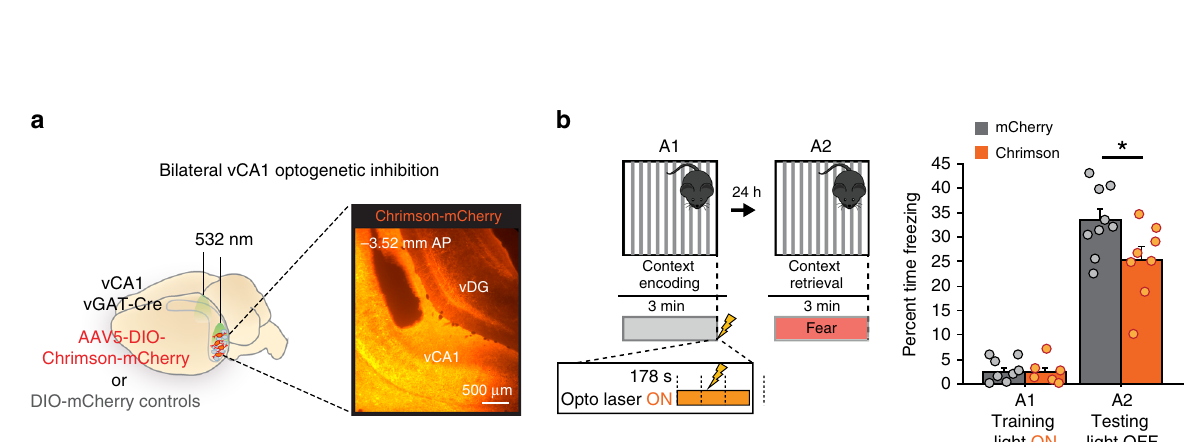
Fig. 2 Correlated activity with vCA1 shock cells is proportional to memory strength. a Experimental design for vCA1 Ca 2 + imaging in contextual conditioning. GCaMP6f was virally expressed and a GRIN lens implanted to target the vCA1 pyramidal layer (left). Ca 2 + activity was imaged across days; Mice received a footshock at the end of A1 (right). The main effect of increased correlated activity in vCA1 during memory retrieval was replicated in fi ve independent datasets. b Correlation graph analysis design; Top: mock traces of Ca 2 + events demonstrating calculation of signi fi cantly correlated pairs (Pearson ’ s R > 0.3, cell 1 correlated with cell 2, but not cell 3). Bottom: Example of a correlation graph with extrapolated graph parameters constructed using Pearson ’ s R correlation matrix. Cell pairs with signi fi cant correlation coef fi cient are connected by a line. c Proportion of vCA1 shock cell correlated pairs with other shock cells (red) or non-shock cells (blue). d Representative correlation graphs with vCA1 shock cells colored in red, and their correlated pairs during context retrieval (A2 shock-partners) colored in blue across conditioning days. e – g Graph parameters of vCA1 shock cells (red), A2 shock- partners (blue), and all other cells (A2 non-shock-partner, black) across conditioning days ( N shock = 111, N A2 shock-partner = 121, N A2 non-shock-partner = 616; Kruskal – Wallis between groups with Bonferroni alpha correction; corr pair ratio: A2 – A1 ** p < 0.0001, H (2) = 49.65, B – A1 p = 0.08, H (2) = 5.01; comp